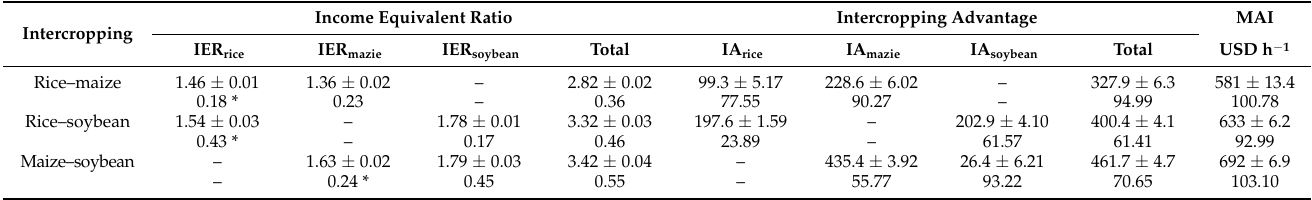
Table 6. The partial income equivalent ratio (IER) for rice, maize, and soybean, and total IER for each cropping system. Intercropping advantage (AI) for rice, maize, and soybean; total AI for each cropping system; and monetary advantage index (MAI) at different IPs in comparison with MPs on the rainfed areas of western Indonesia with a wet